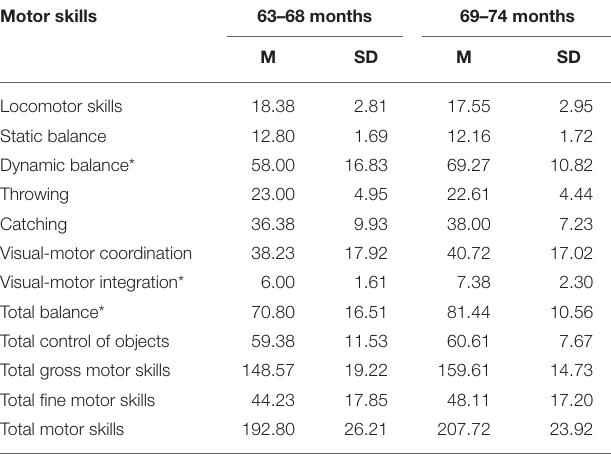
TABLE 5 | Means (M) and Standard Deviations (SD) of motor skills scores according to age. Motor